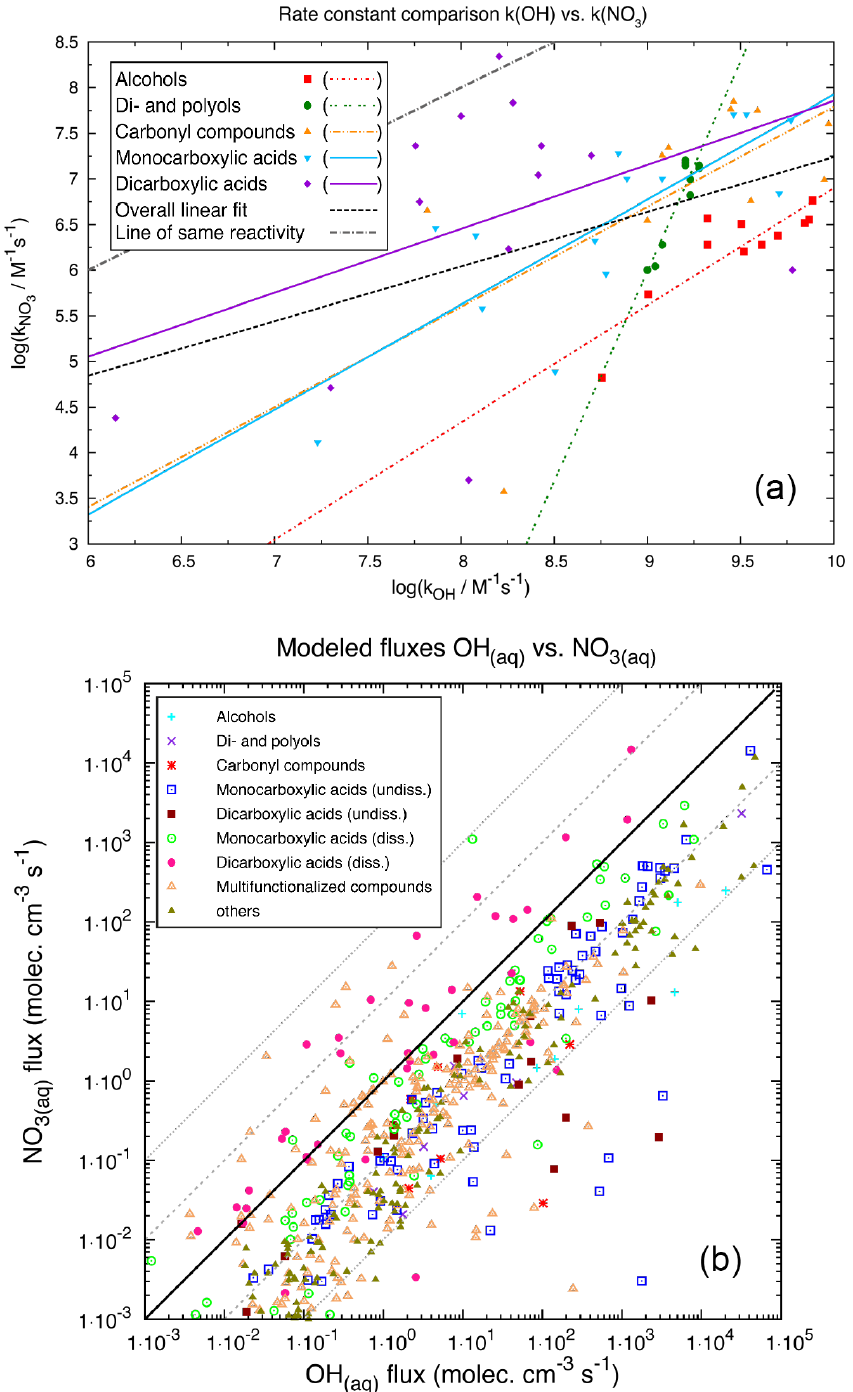
Figure 4. (a) Correlation of OH versus NO 3 radical rate constants in the aqueous phase for the respective compound classes. The linear regression fits for the different compound classes are presented in the same color as the respective data points. The black line represents the correlation of the overall data. (b) Comparison of modeled, aqueous-phase reaction fluxes (mean chemical fluxes in molcm − 3 s − 1 over a simulation period of 4–5 days) of organic compounds with hydroxyl (OH) versus nitrate (NO 3 ) radicals distinguished by different compound classes (urban CAPRAM summer